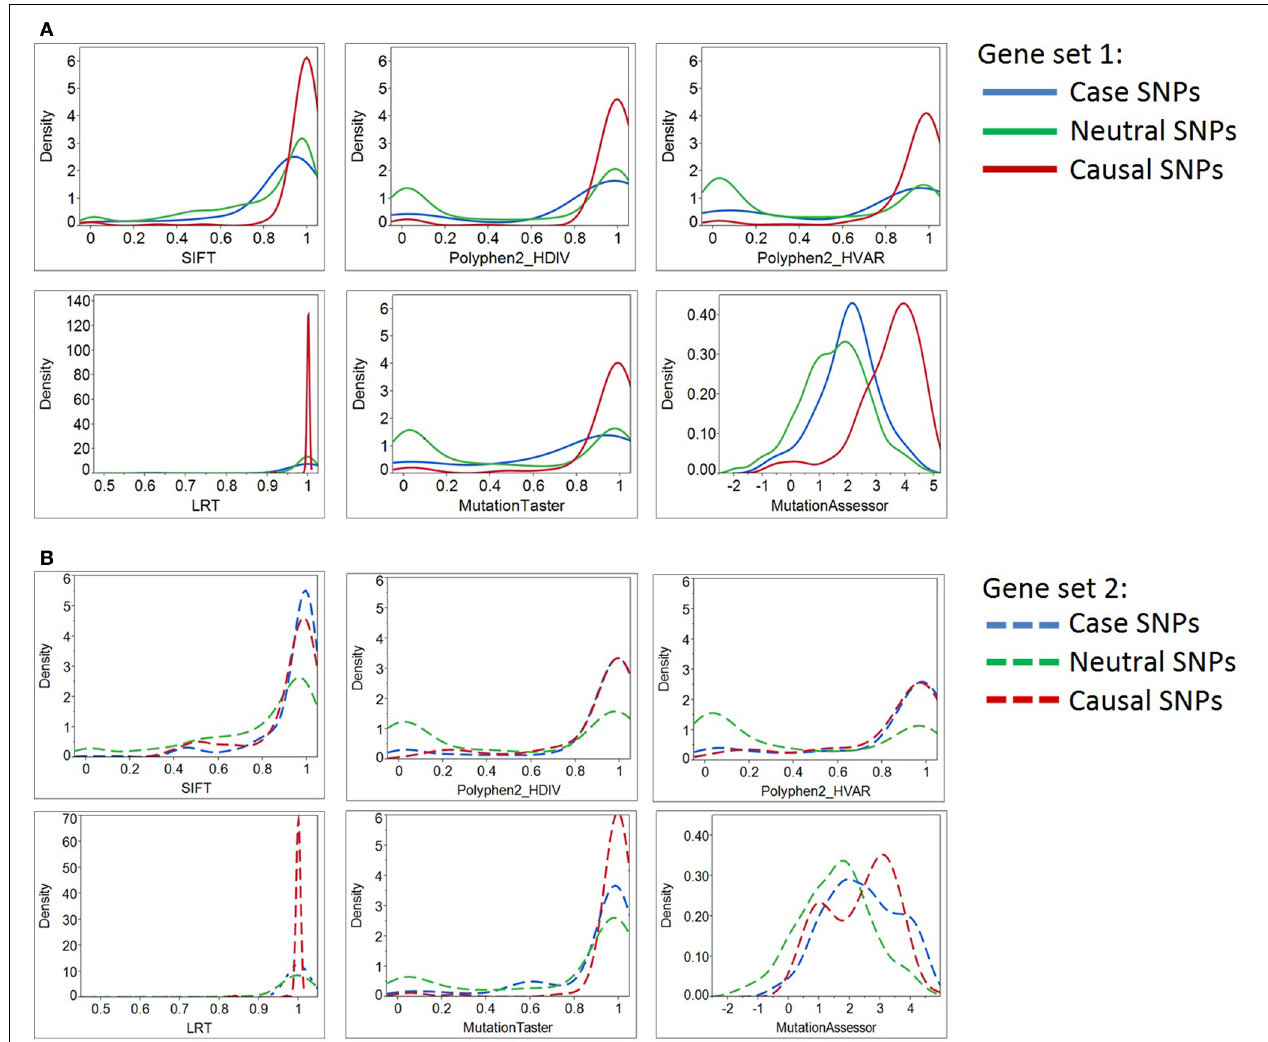
FIGURE 2 | Density plots of six deleterious scores for Case, Neutral, and Causal SNPs. By most of the standard deleteriousness scores, the distributions of cases in gene set 1 (Panel A ) are closer to the neutral than the causal variants, and the neutral and causal variants are significantly different. The “known epilepsy” dataset (gene set 2, Panel B ) demonstrated similar results. In this gene set, variants documented to cause epilepsy were regarded as “cases,” while variants associated with